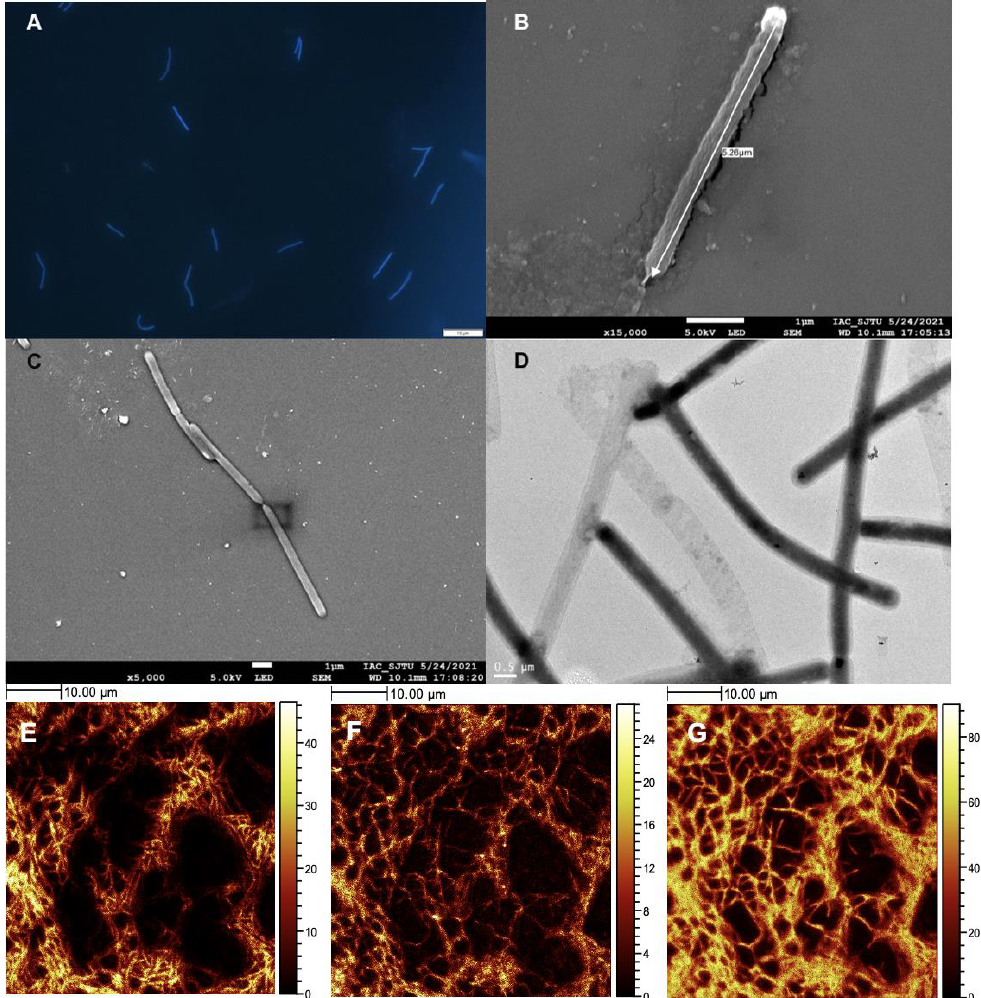
Figure 2. Cells of Methanothermobacter tengchongensis DL9LZB001 under a microscope and in ToF-SIMS images. ( A ) Under a fluorescence microscope with 405 nm ultraviolet light as the light source. ( B , C ) Under a scanning electron microscope. The length of DL9LZB001 in these images is 5 .26 μm, and the diameter is approximately 0.4 μm. ( D ) DL9LZB001 cells under a transmission electron microscope. ( E – G ) ToF-SIMS ion images of dried cultured cell aggregates showing their morphology and components. The lighter parts in the pictures are signals of ( E ) C 2 SO 2+ , ( F ) a combination of PO 3 – , PO 2 – , and PO – , and ( G ) CN – . The darker parts are sections without signal (without cells). The scale bar on the right displays the strength of the signal.